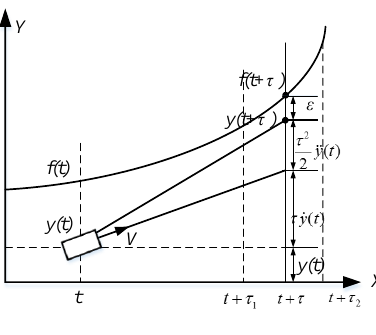
Figure 4. Human diver model.